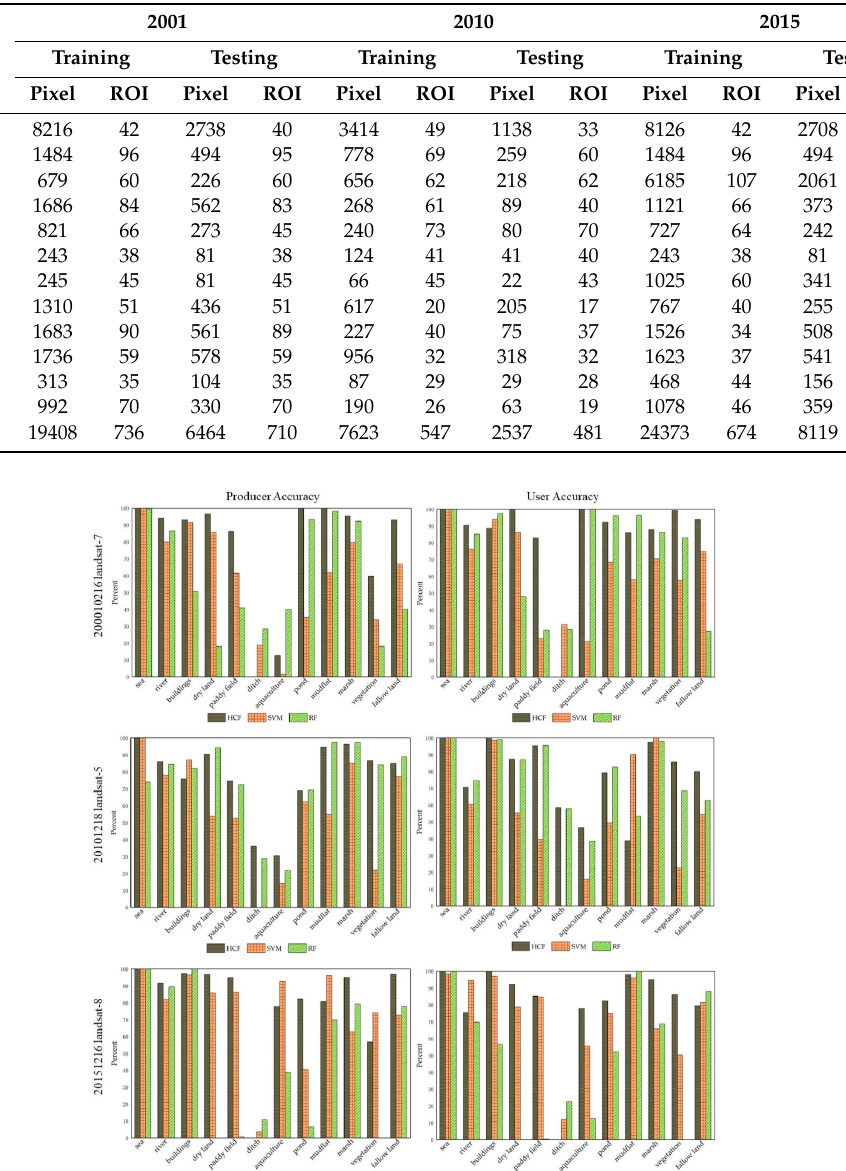
Table 5. Training and testing samples of 12 land covers for Yancheng coastal wetland.